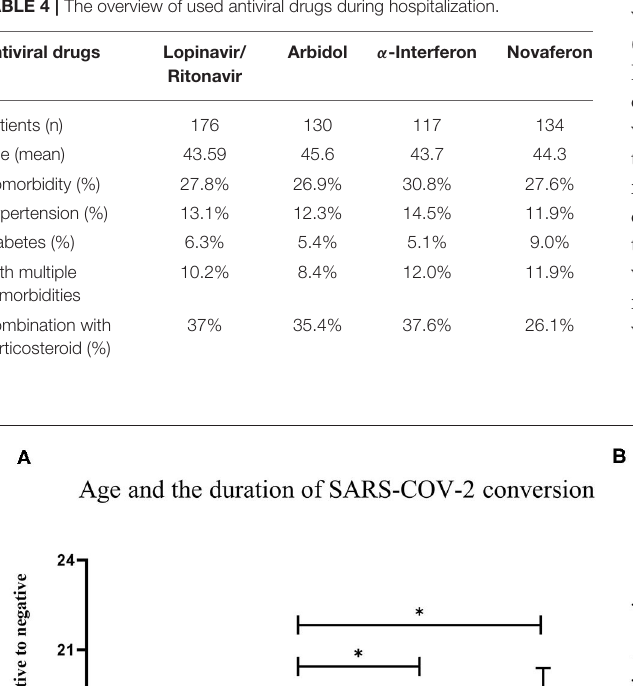
TABLE 4 | The overview of used antiviral drugs during hospitalization.